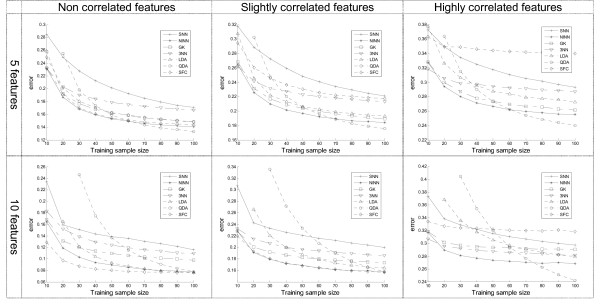
Comparison of various classifiers for low-curvature nonlinear model.